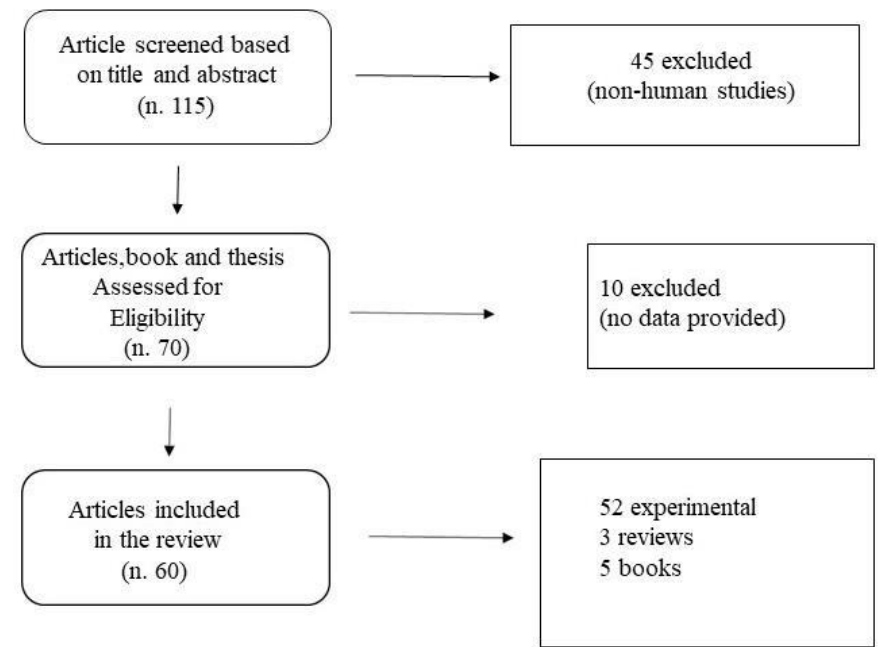
Figure 1. Flow Chart of Literature selection.